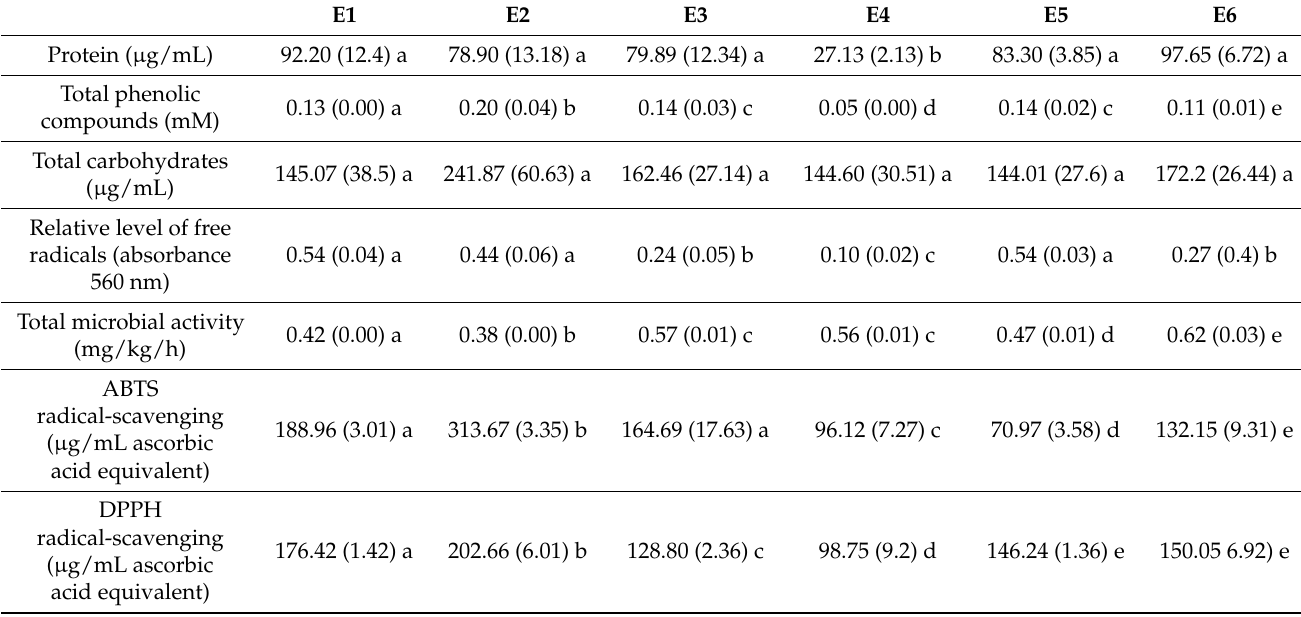
Table 1. Concentration of proteins, phenolic compounds (PC), total carbohydrate (TC), relative level of superoxide anion radicals (SOR), and total microbial activity in the extracts obtained from the ant nest carton. Values with different letters (a–e) are statistically significant ( p <